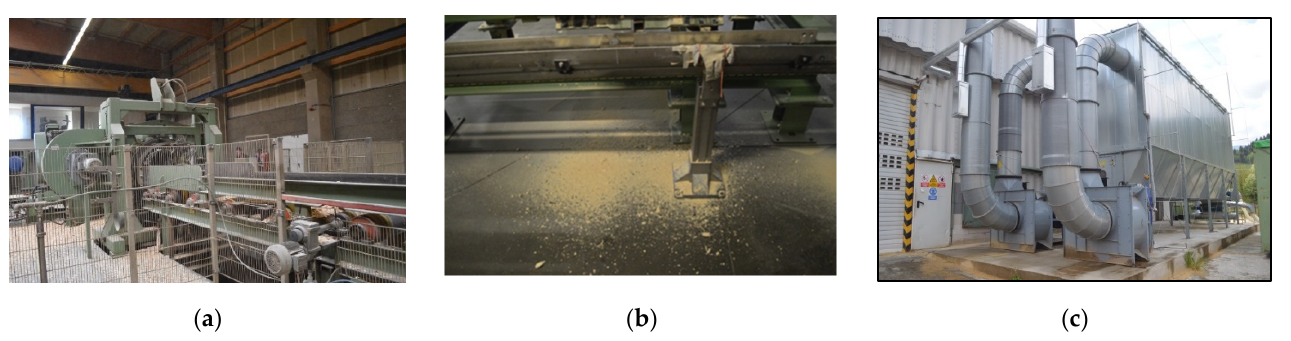
Figure 1. Samples of the sampling point. ( a ) Wood sawing line; ( b ) Briquette production line; ( c ) Extraction device.